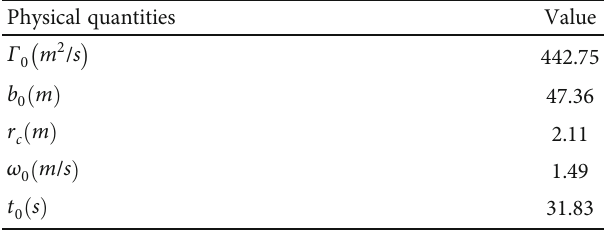
Table 3: Partial parameters of the wake